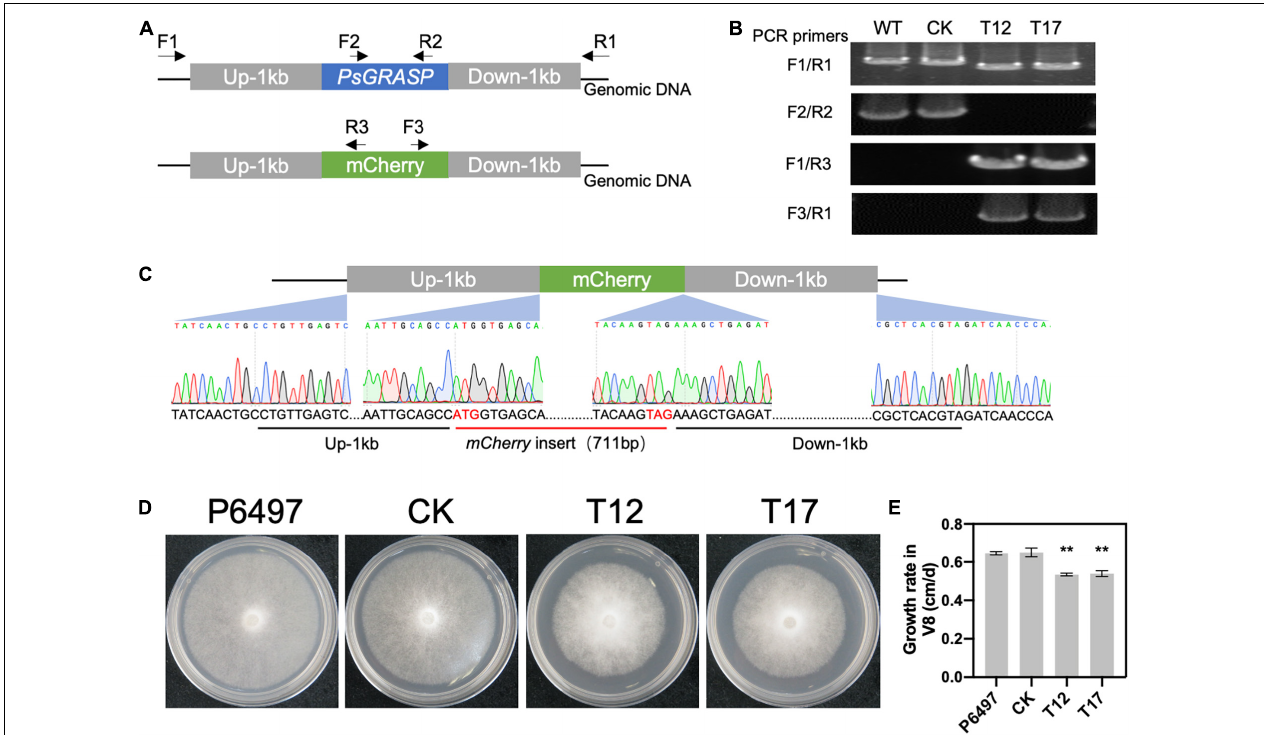
FIGURE 2 | CRISPR-mediated gene replacement of PsGRASP and the colony morphology of PsGRASP -knockout mutants. (A) Locations of the primers used to screen the HDR mutants. (B) Analysis of genomic DNA from the wild-type (P6497), two PsGRASP -knockout mutants (T12 and T17), and an unsuccessful knockout line (CK) using the primers shown in (A) . (C) Sanger sequencing of the junction regions confirmed that the PsGRASP ORF has been precisely replaced by the mCherry gene. (D) Colonies of P6497, CK, T12, and T17 were cultured on 10% V8 agar medium at 25 ◦ C in the dark for 5 days. (E) the quantified growth rates of the indicated colonies from (D) . Each experiment was repeated three times. Scale bars denote SD. ** P < 0.01, Student’s t -test.